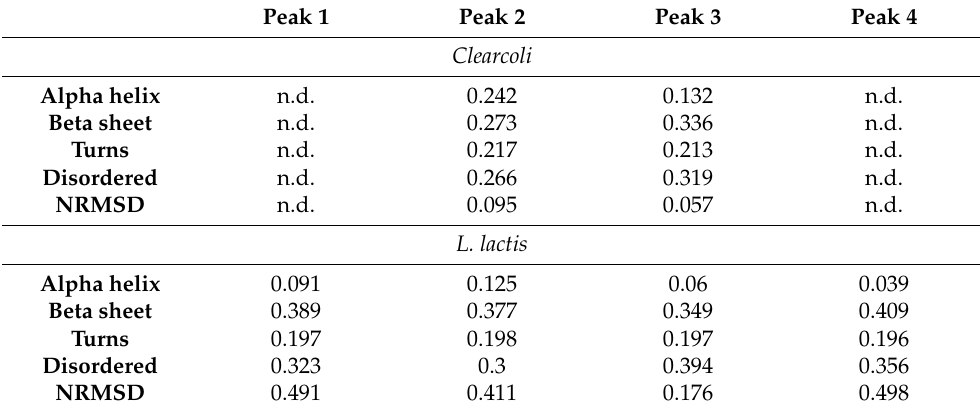
Table 2. Secondary structure contents of the MMP-9 protein obtained by deconvoluting far-UV CD spectra. Peak 1 Peak 2 Peak 3 Peak